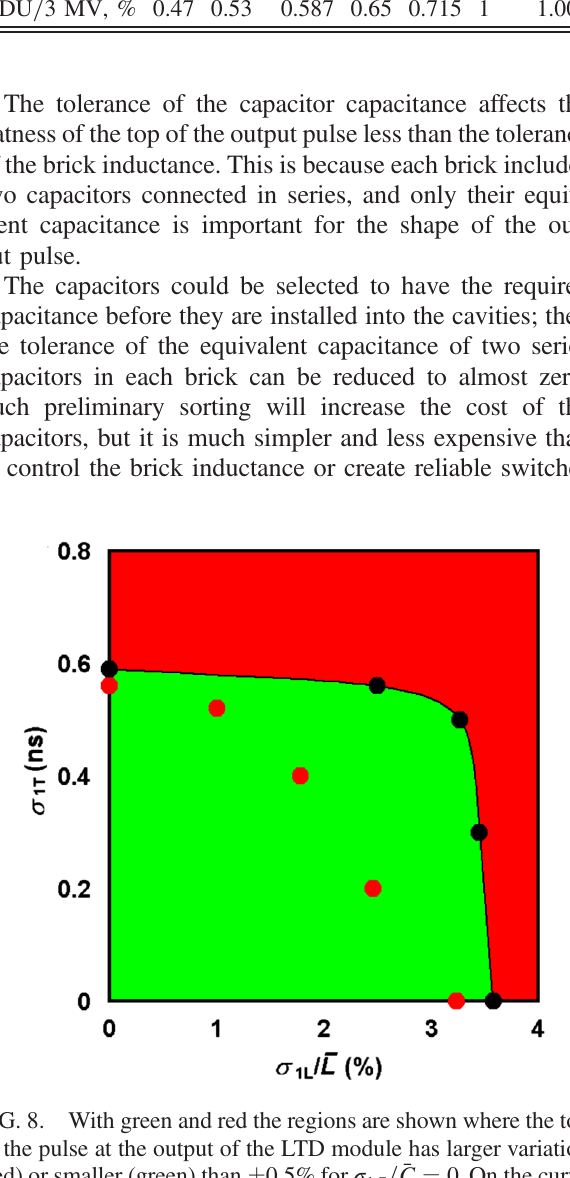
¯ C ¼ 0 . On the curve ¯ C ¼ 3 . 33 % is in-